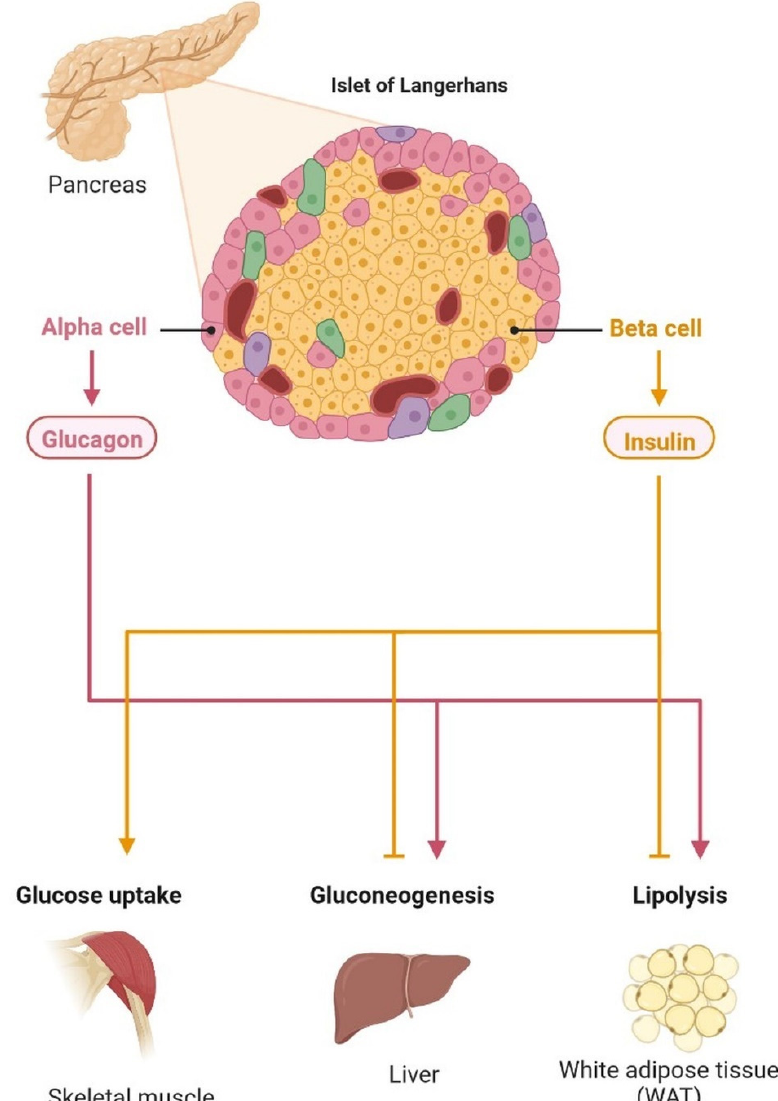
Figure 4. Neuronal control of peripheral insulin sensitivity and glucose metabolism. The pancreatic islets contain alpha and beta cells, which regulate glucagon and insulin, respectively. Insulin lowers the effects of glucose uptake in the skeletal muscles, liver, and brain. Blood glucose is increased by glucagon during the gluconeogenesis and lipolysis processes. The energy level is maintained by the brain in various parts of the body with a glucose homeostasis mechanism.